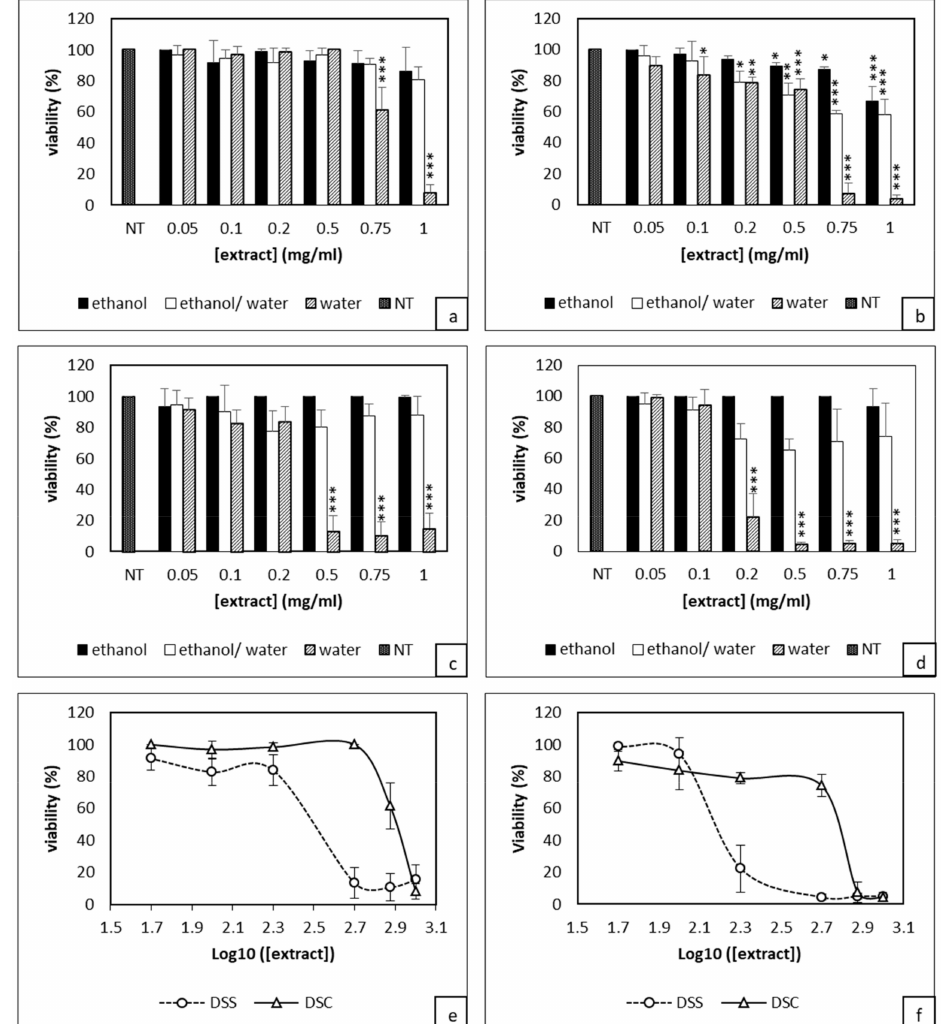
Figure 1. Evaluation of Dunaliella extracts from normal (DSC) or stressed (DSS) conditions e ff ect on 4T1 cells viability through XTT assay. Cells were treated with either DSC ( a , b ) or DSS (c,d) for either 24h ( a , c ) or 48h ( b , d ). Estimation of IC 50 values after 24h ( e ) and 48 h ( f ) of DSC and DSS treatments. Results shown are mean values ± standard deviation of three independent experiments (*** p < 0.001; ** p < 0.01; * p < 0.05) according to One-way ANOVA using